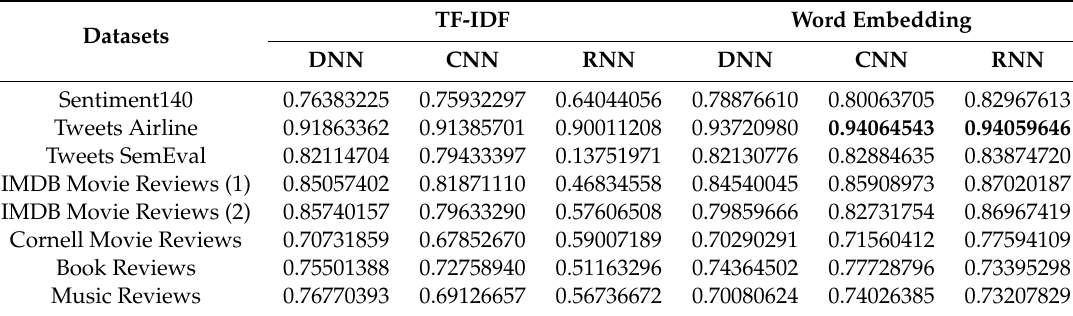
Table 5. The F-score comparison for di ff erent datasets.